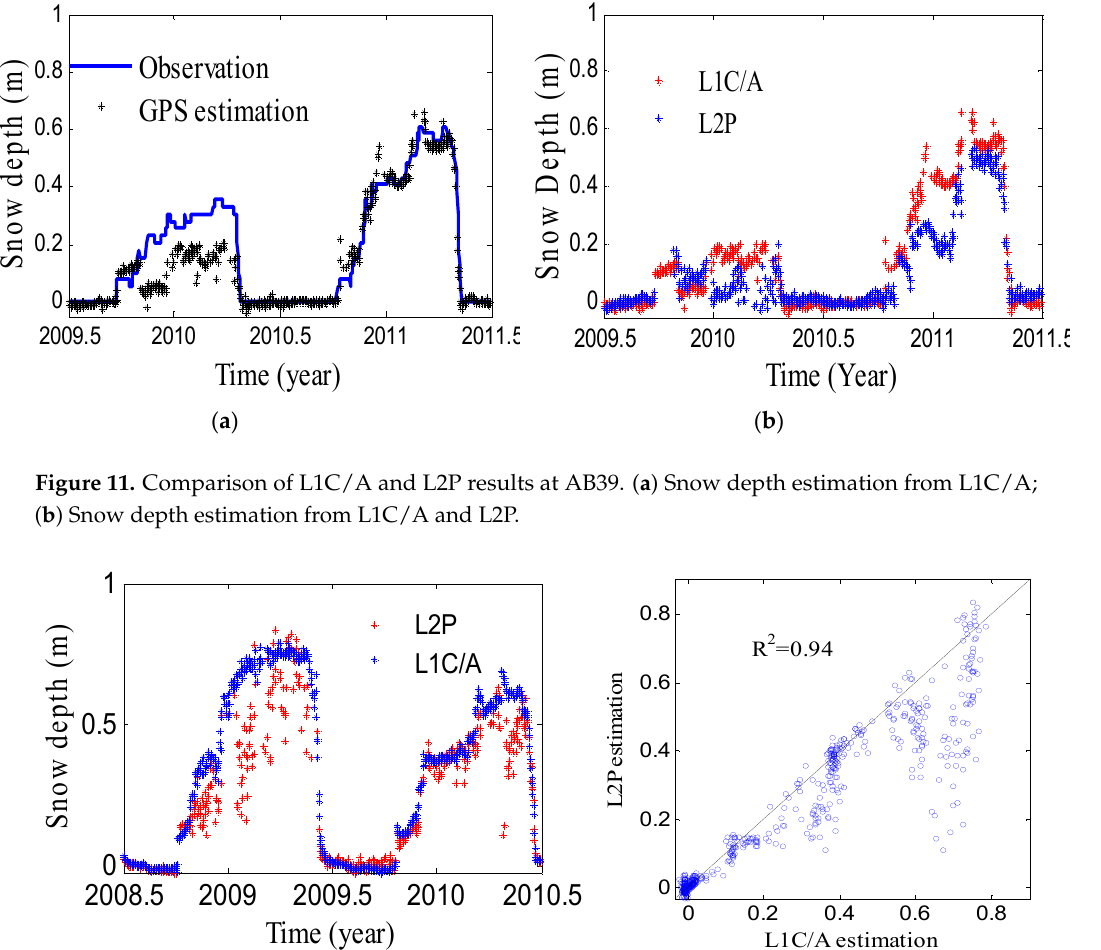
Figure 10. Comparison of L1C/A and L2P results at AB33. ( a ) Snow depth estimation from L1C/A; ( b ) Snow depth estimation from L1C/A and L2P.